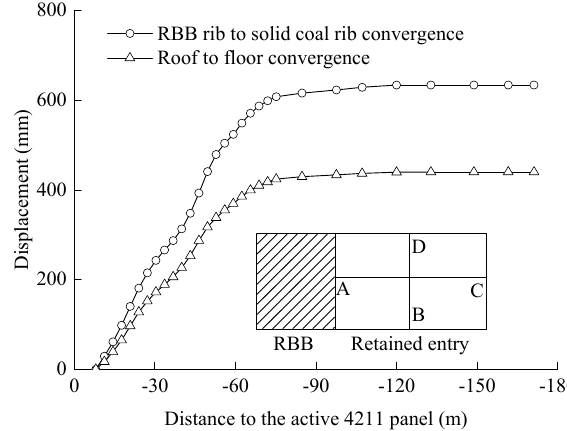
Figure 16. Monitoring results of the surrounding rock displacement.